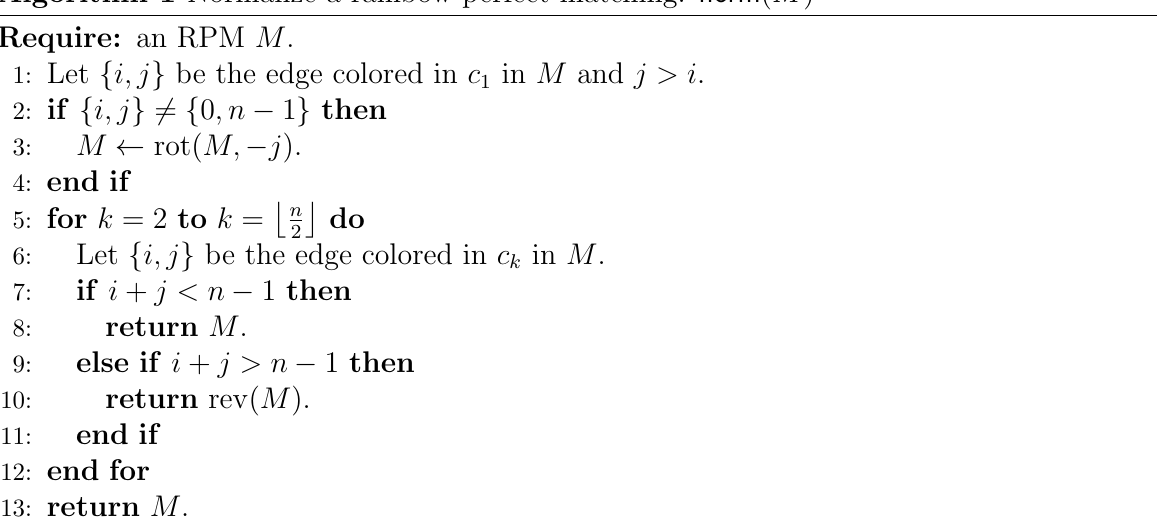
Algorithm 1 Normalize a rainbow perfect matching: norm ( M